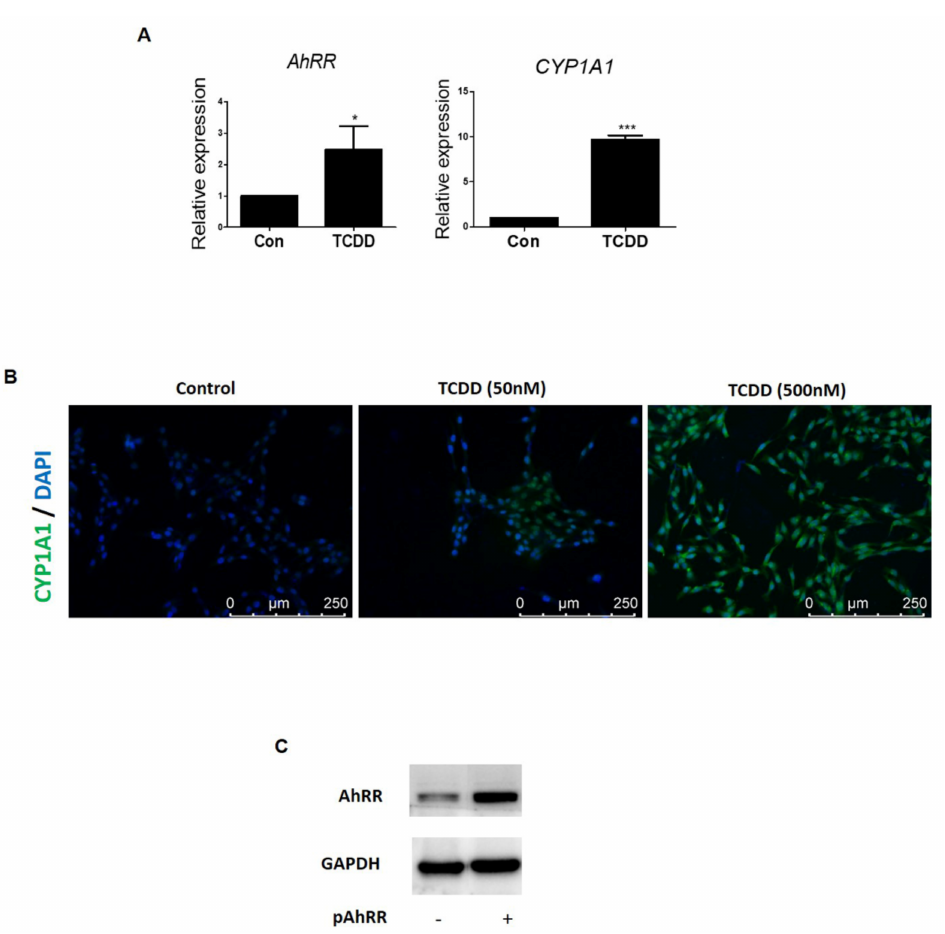
Figure 3. Effect of TCDD on AhRR expression in HaCaT cells. HaCaT cells were treated with TCDD 500 nM for 24 h. ( A ) AhRR and CYP1A1 mRNA expression was examined by qPCR. ( B ) Localization of CYP1A1 was determined by immunofluorescence staining (scale bar: 250 µ m). ( C ) HaCaT cells were treated with TCDD 500 nM (24 h) and transfected with pAhRR for 48 h. AhRR protein level was examined by Western blot. Values are means ± SEM. All experiments of at least three independent experiments. * p < 0.05 vs. control, *** p < 0.001 vs.